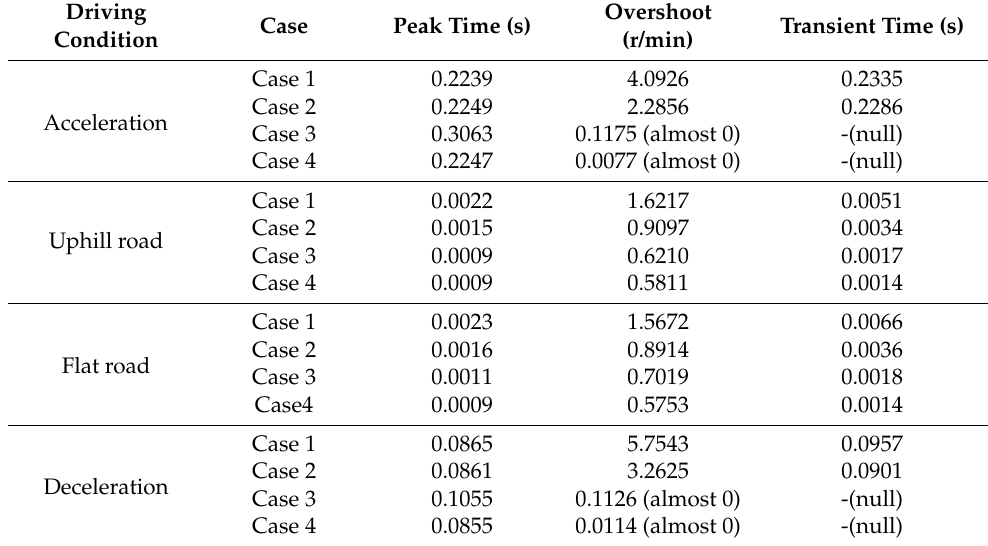
Table 2. Comparison of speed dynamic response in all cases.